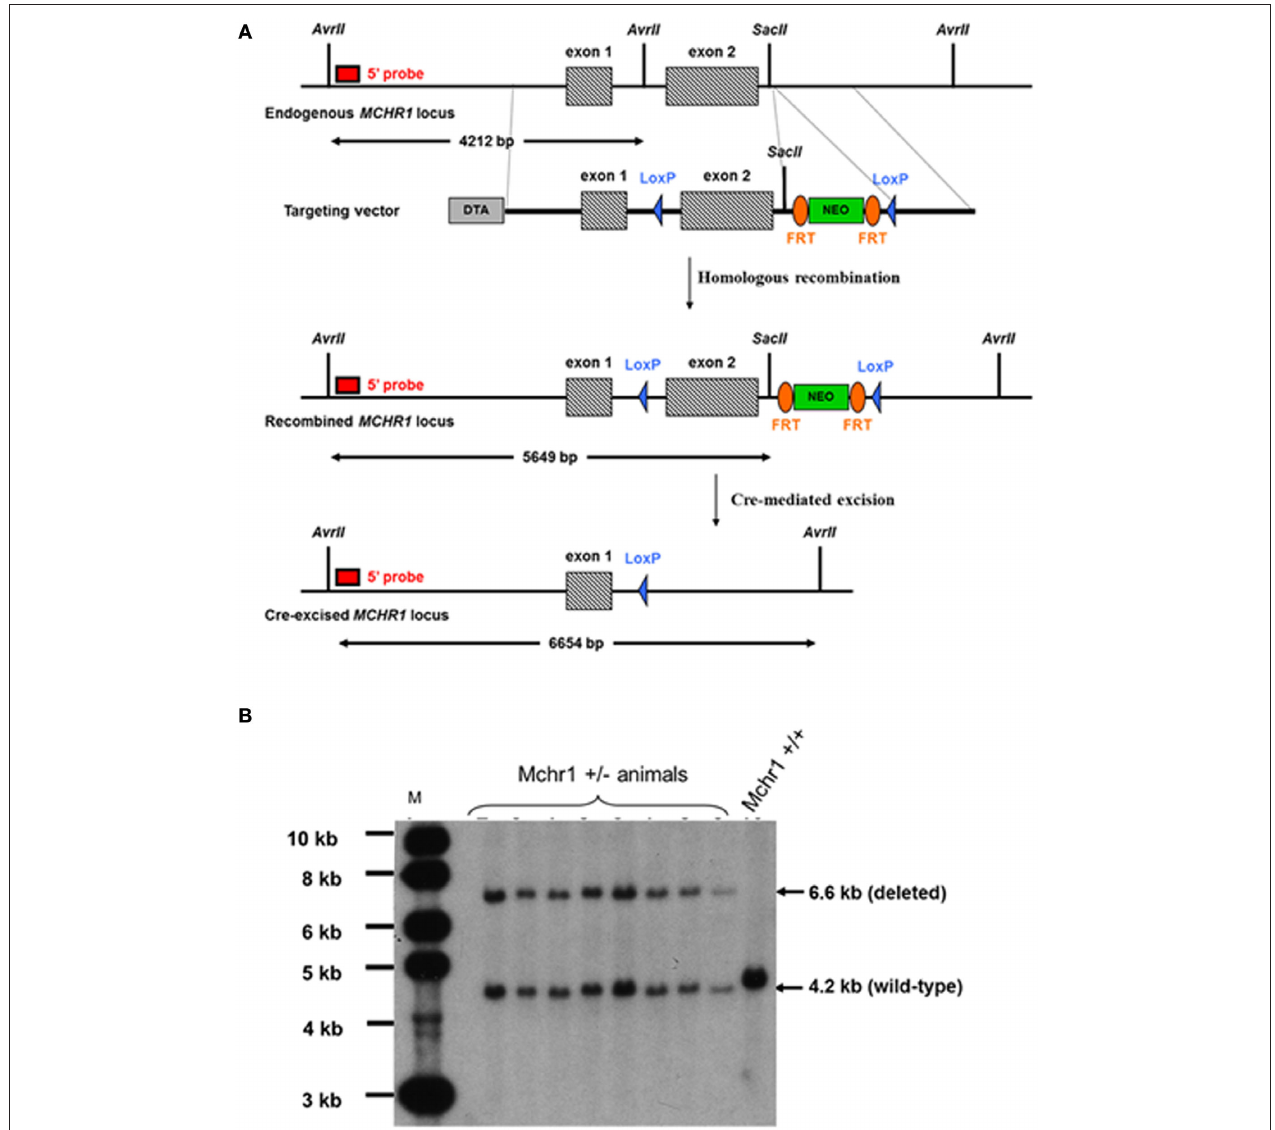
FIGURE 1 | Construction of MCHR1 − / − mice. (A) Strategy for the construction of MCHR1 − / − mice. The Mchr1 locus (containing exons 1–2) and the targeting construct [containing the neomycin (PGK-Neo) cassette with flanking segments homologous to the locus] are shown. The probe used in all Southern blot analyses was a 0.65-kb